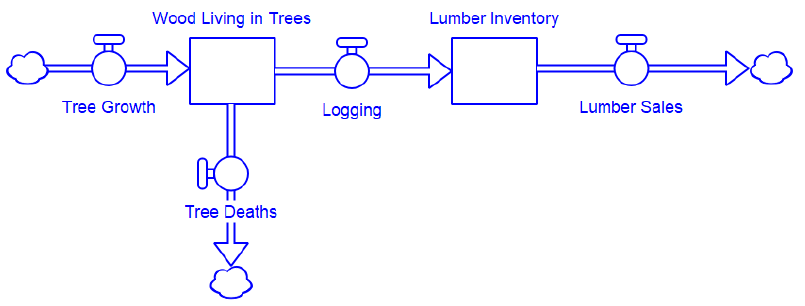
Fig. 2. A basic stock-and-flow diagram [36]